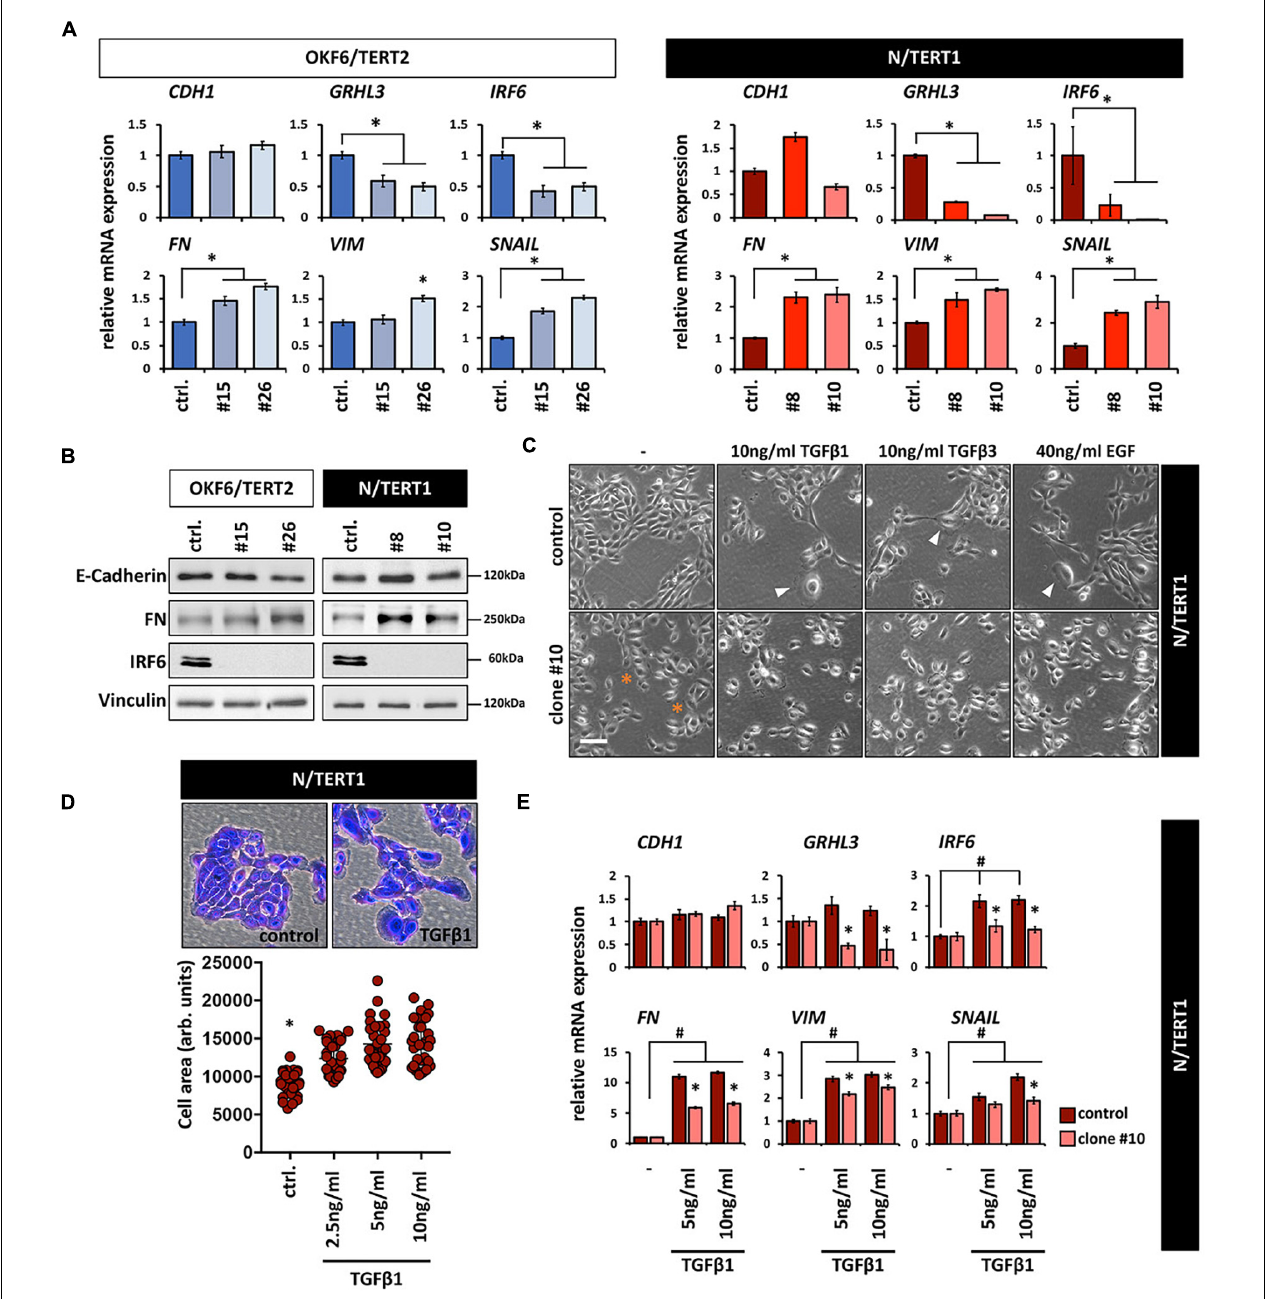
FIGURE 3 | (A) qPCR analyses for the epithelial markers CDH1 , GRHL3 , and IRF6 as well as for the mesenchymal markers FN , VIM , and SNAIL in OKF6/TERT2 (left) and N/TERT1 (right) cell lines. Note that although there is a slight increase of the mesenchymal markers, CDH1 does not decrease in the absence of IRF6. ctrl.: control; ∗ p < 0.05 controls vs. clones #15, #26, #8, #10. (B) Immunoblots confirm the qPCR results and show no change in E-Cadherin, but an increase in FN, and absence of IRF6 in the clones. kDa: kilo Dalton; ctrl.: control. (C) Treatment of N/TERT1 controls (top row) with the EMT-inducing growth factors EGF, TGF β 1, and TGF β 3 for 72 h induces changes in the cellular morphology with scattered and enlarged cells (arrowheads). In N/TERT1 clone #10 (bottom row) a similar morphological phenotype can already be appreciated without addition of growth factors. ∗ indicates enlarged cells. Scale bar: 150 µ m. (D) Crystal violet staining and cell area analysis of N/TERT1 control in the absence and presence of TGF β 1 (72 h) reveals the emergence of enlarged cells in the presence of the growth factor. ∗ p < 0.05 control vs. TGF β 1-treated cells; ctrl.: control. (E) qPCR analyses for the mesenchymal markers FN , VIM , and SNAIL as well as the epithelial markers CDH1 , IRF6 , and GRHL3 in TGF β 1-treated (72 h) cells in the presence (control) or absence (clone #10) of IRF6. Note that the mesenchymal markers as well as IRF6 increase, while CDH1 does not change. Also note that IRF6 is required for a proper modulation of all these markers. # p < 0.05 untreated vs. TGF β 1-treated cells; ∗ p < 0.05 control vs. IRF6 knockout cells (clone #10). Full-length immunoblots are shown in Supplementary Figure 9